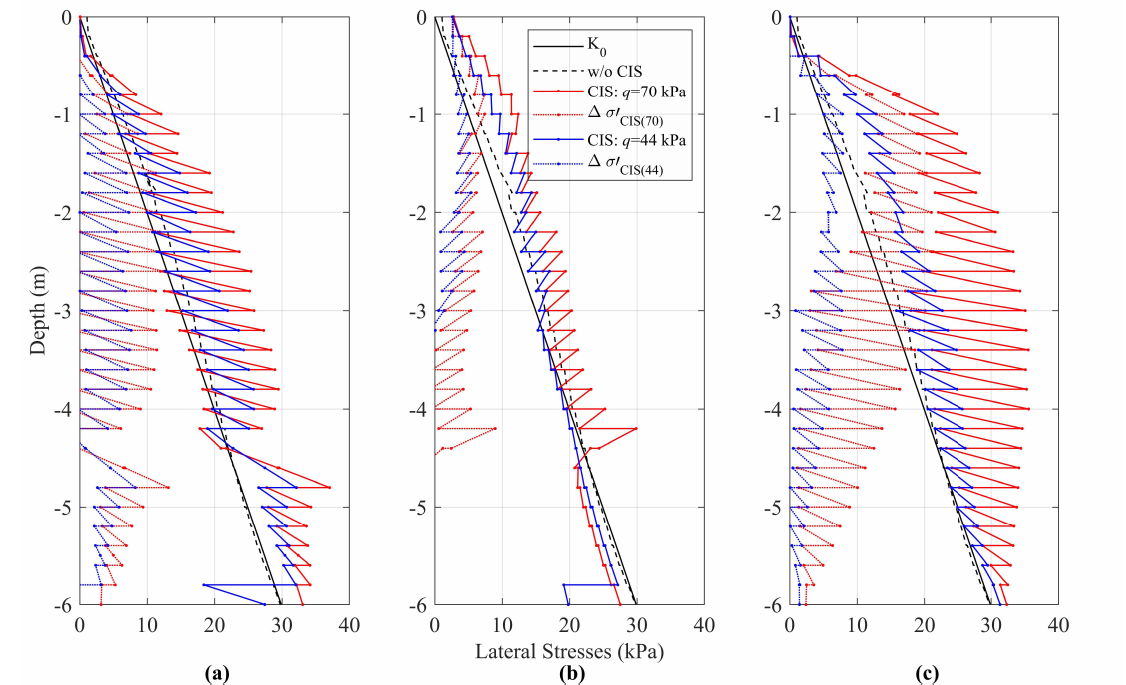
Figure 10. Distribution of lateral stresses along the centre line of the hypothetical GRS mass during construction stage, for cases of q = 44 and 70 kPa, and compaction procedures: ( a ) Type-I; ( b ) Type-II; ( c ) Type-III ( w = 0.7